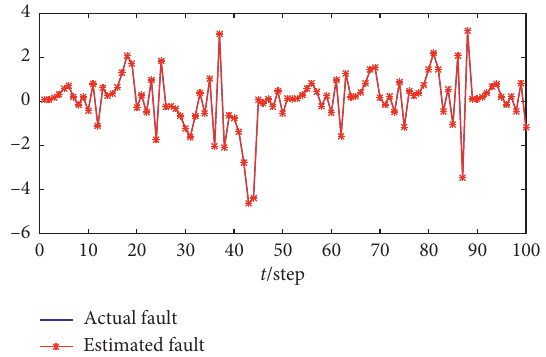
Figure 6: Log (actual estimation variances) of the fault and its upper